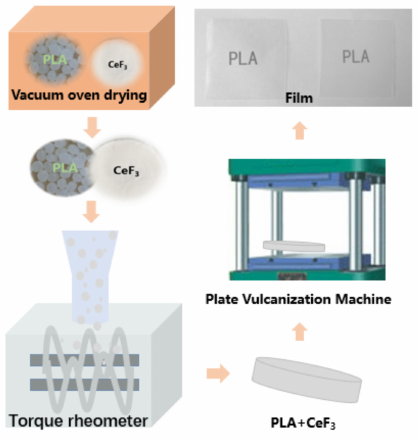
Figure 1. Schematic illustration of the preparation of P/F